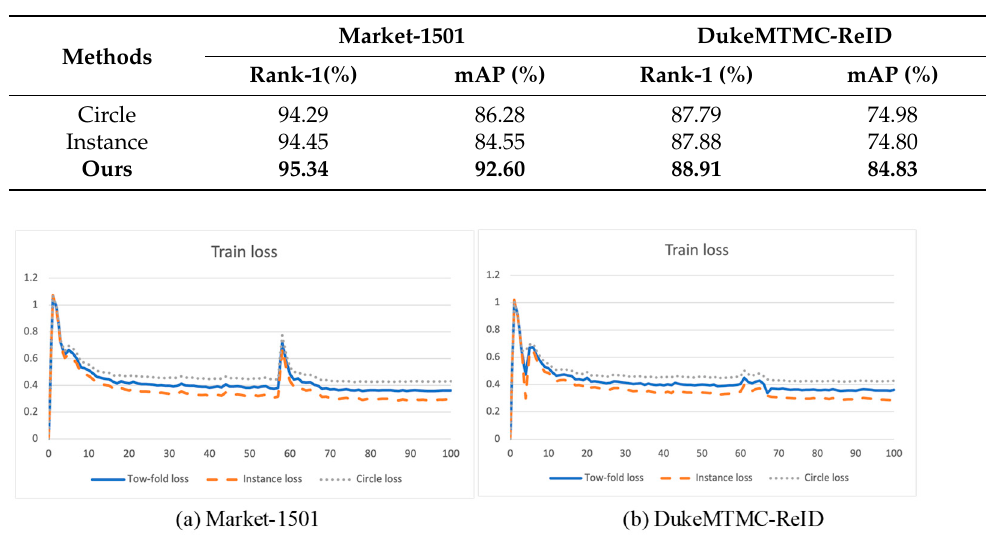
Figure 6. Loss function curves when training on Person Re-ID datasets.